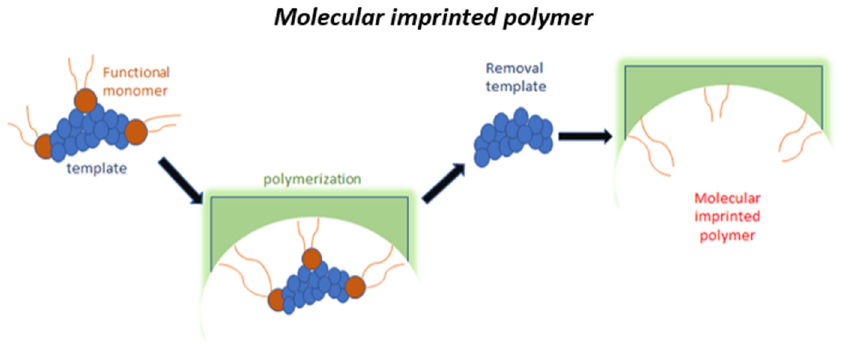
Figure 3. Graphical scheme of MIPs assembling.